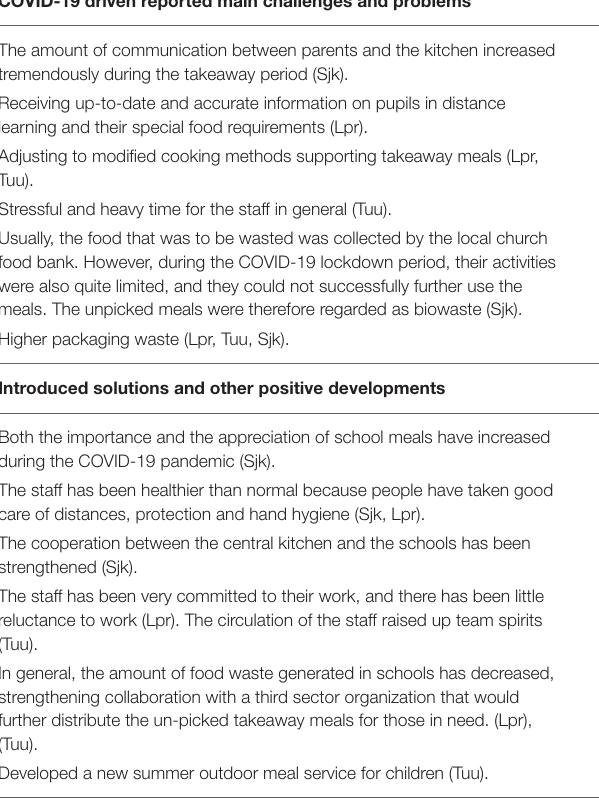
TABLE 5 | Challenges and positive developments during COVID-19 in two Polish municipalities. COVID-19 driven reported main challenges and